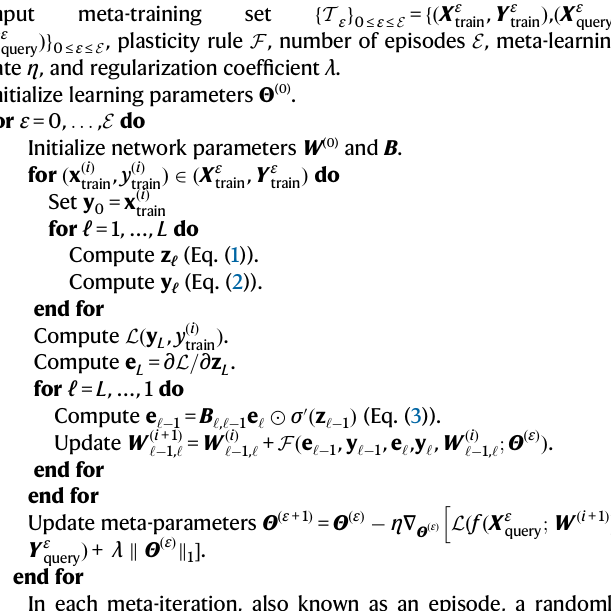
Algorithm 1 . Meta-learning algorithm .